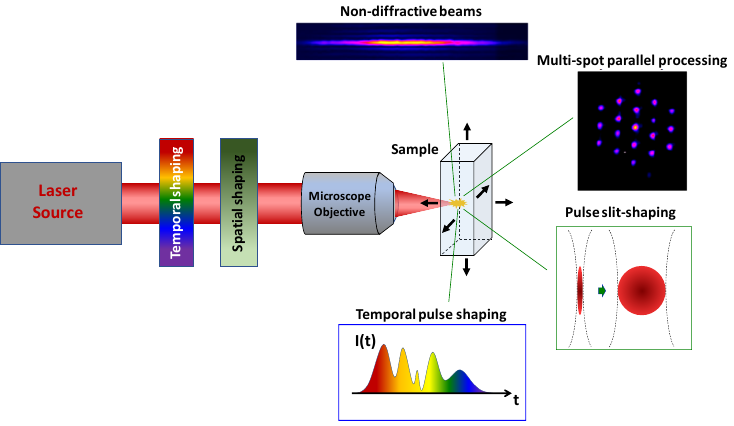
Figure 1. Spatio-temporal beam engineering methods using spatial and spectral phase modulation beam shaping in space and time domains. Examples of non-diffractive beams generation, parallel processing, beam slit-shaping, and time-envelope shaping are indicated.